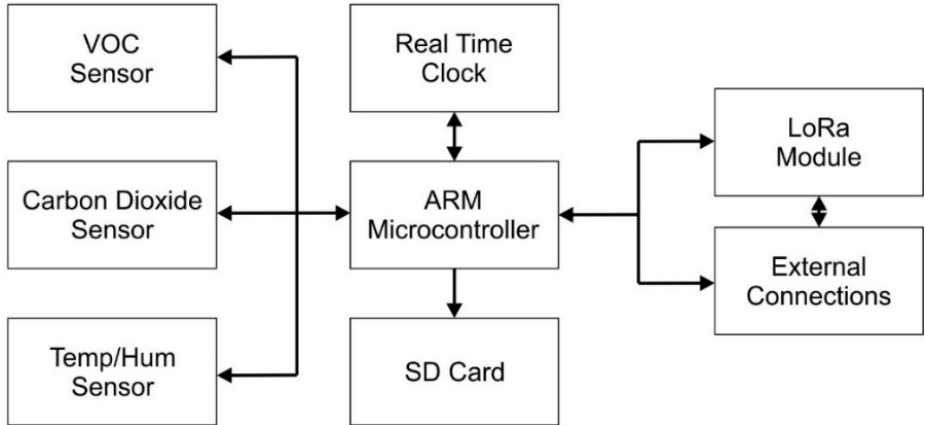
Figure 2. System block diagram.